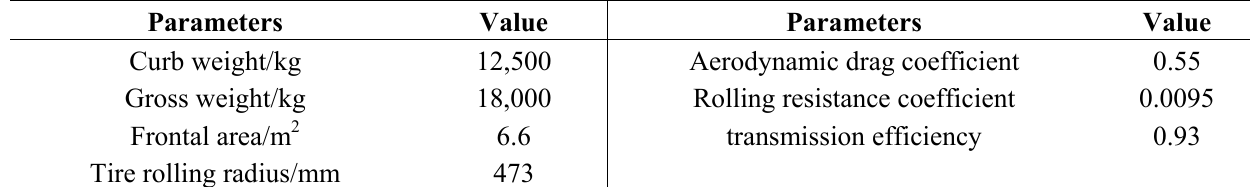
Table 1. The PHEB main